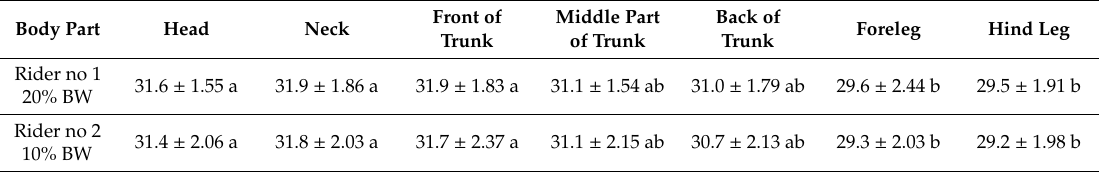
Table 4. Resting average superficial temperatures ( ◦ C) of the studied body parts of the horse (Means ±